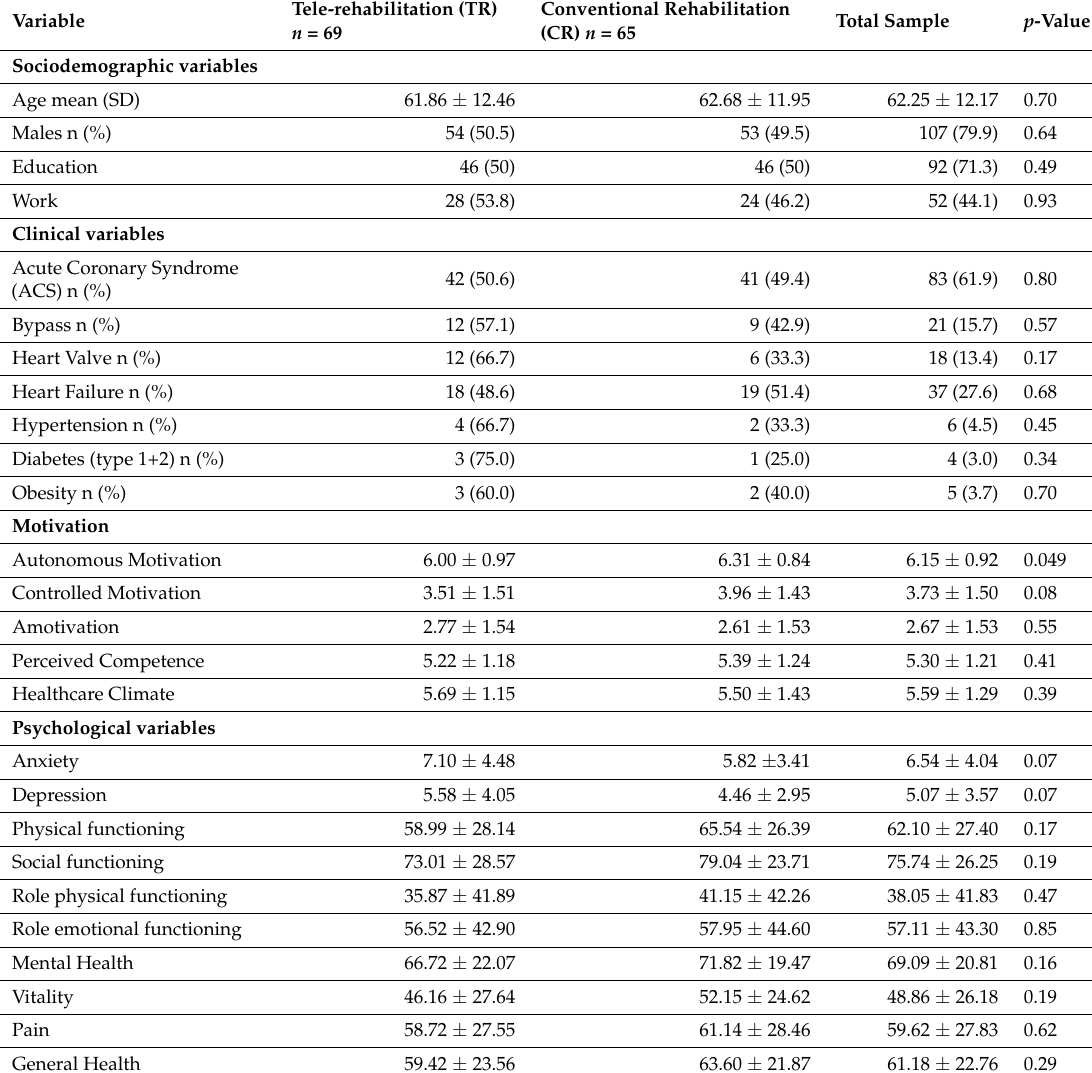
Table 1. Statistical comparison of baseline characteristics between